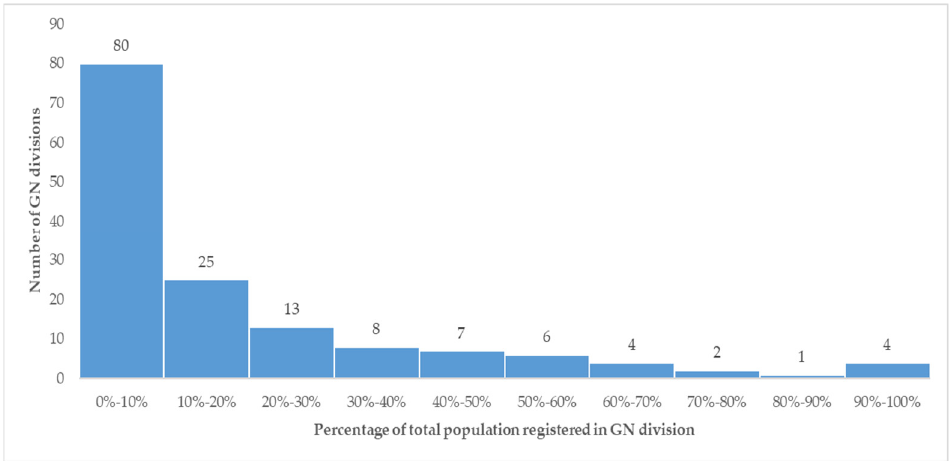
Figure 3. Histogram depicting the number of GN divisions and their percentage of the total popu ‐ lation registered in the nine selected PMCIs supported by the PSSP in Sri Lanka, 2021. Note: GN division—Grama Niladhari division (most peripheral administrative unit in Sri Lanka).